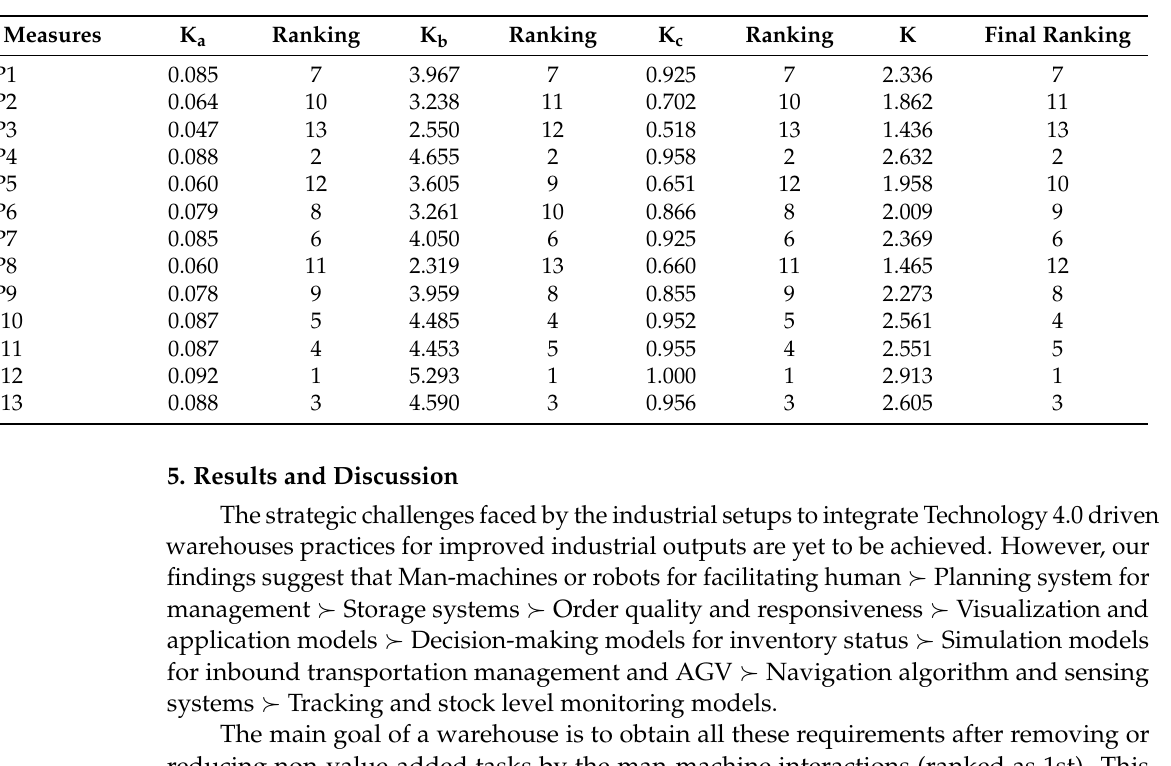
Table 13. Relative weights, final weigh and raking of warehousing performance